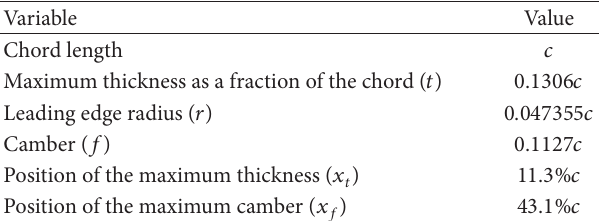
Table 1: Parameters of the bionic airfoil.